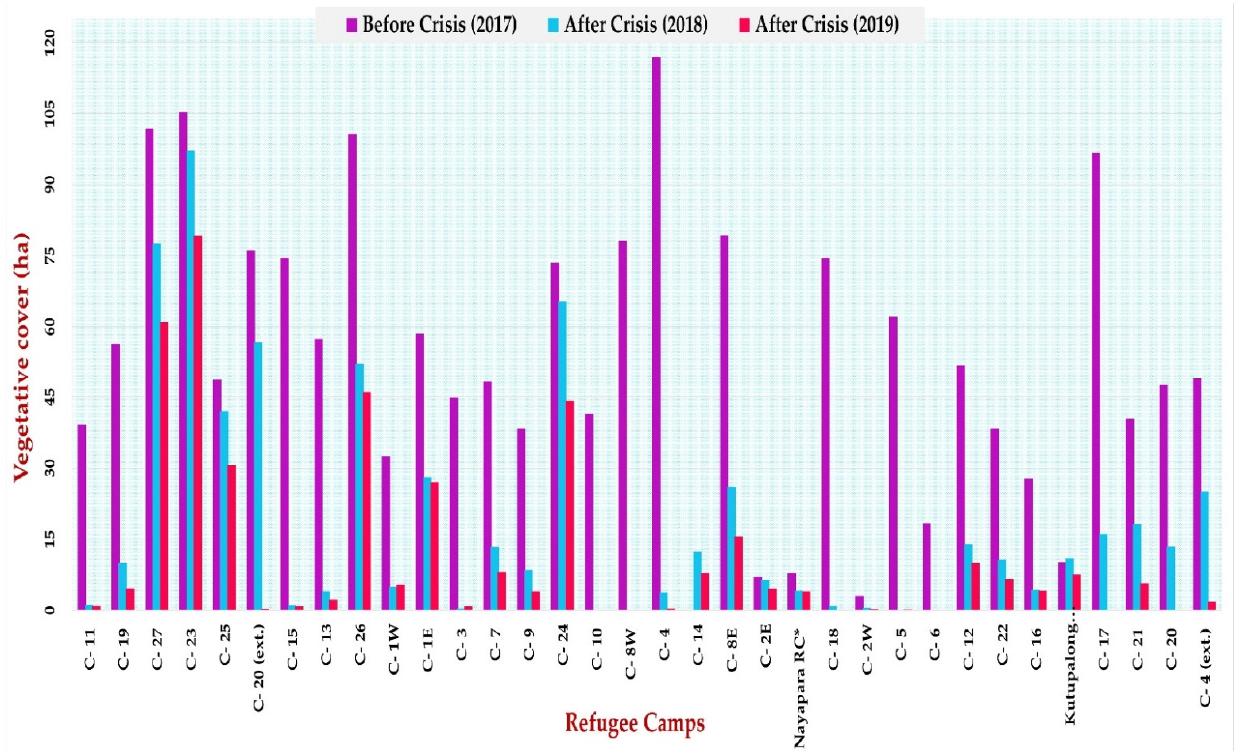
Figure 7. Camp-wise vegetative cover changes, pre and post refugee crisis (between 2017 and 2019), among thirty-four refugee camps in Ukhiya-Teknaf. Here, C = camp; RC* = registered camp; Ext. = extension.